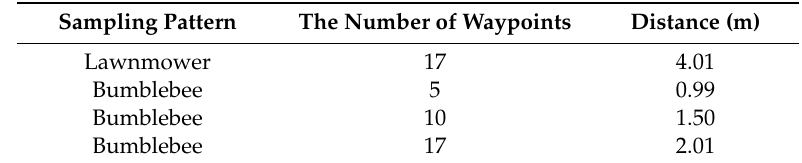
Table 3. The total distance required for detection.